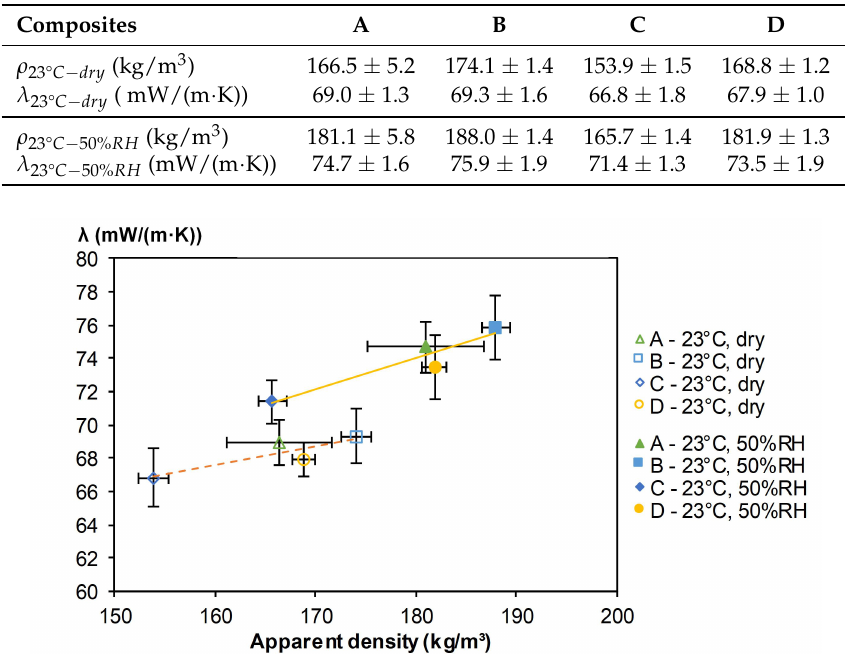
Figure 11. Thermal conductivity of composites at (23 °C, dry) and at (23 °C,